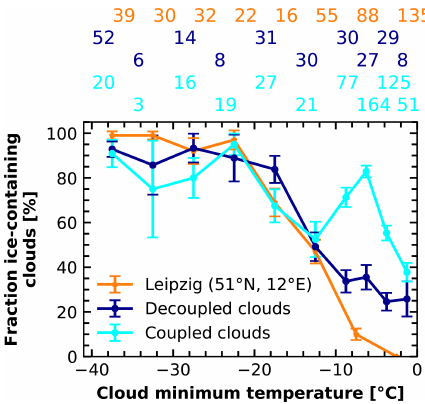
Figure 5. Same as Fig. 4a with the Arctic clouds separated by their coupling state (cyan: coupled clouds; dark blue: decoupled